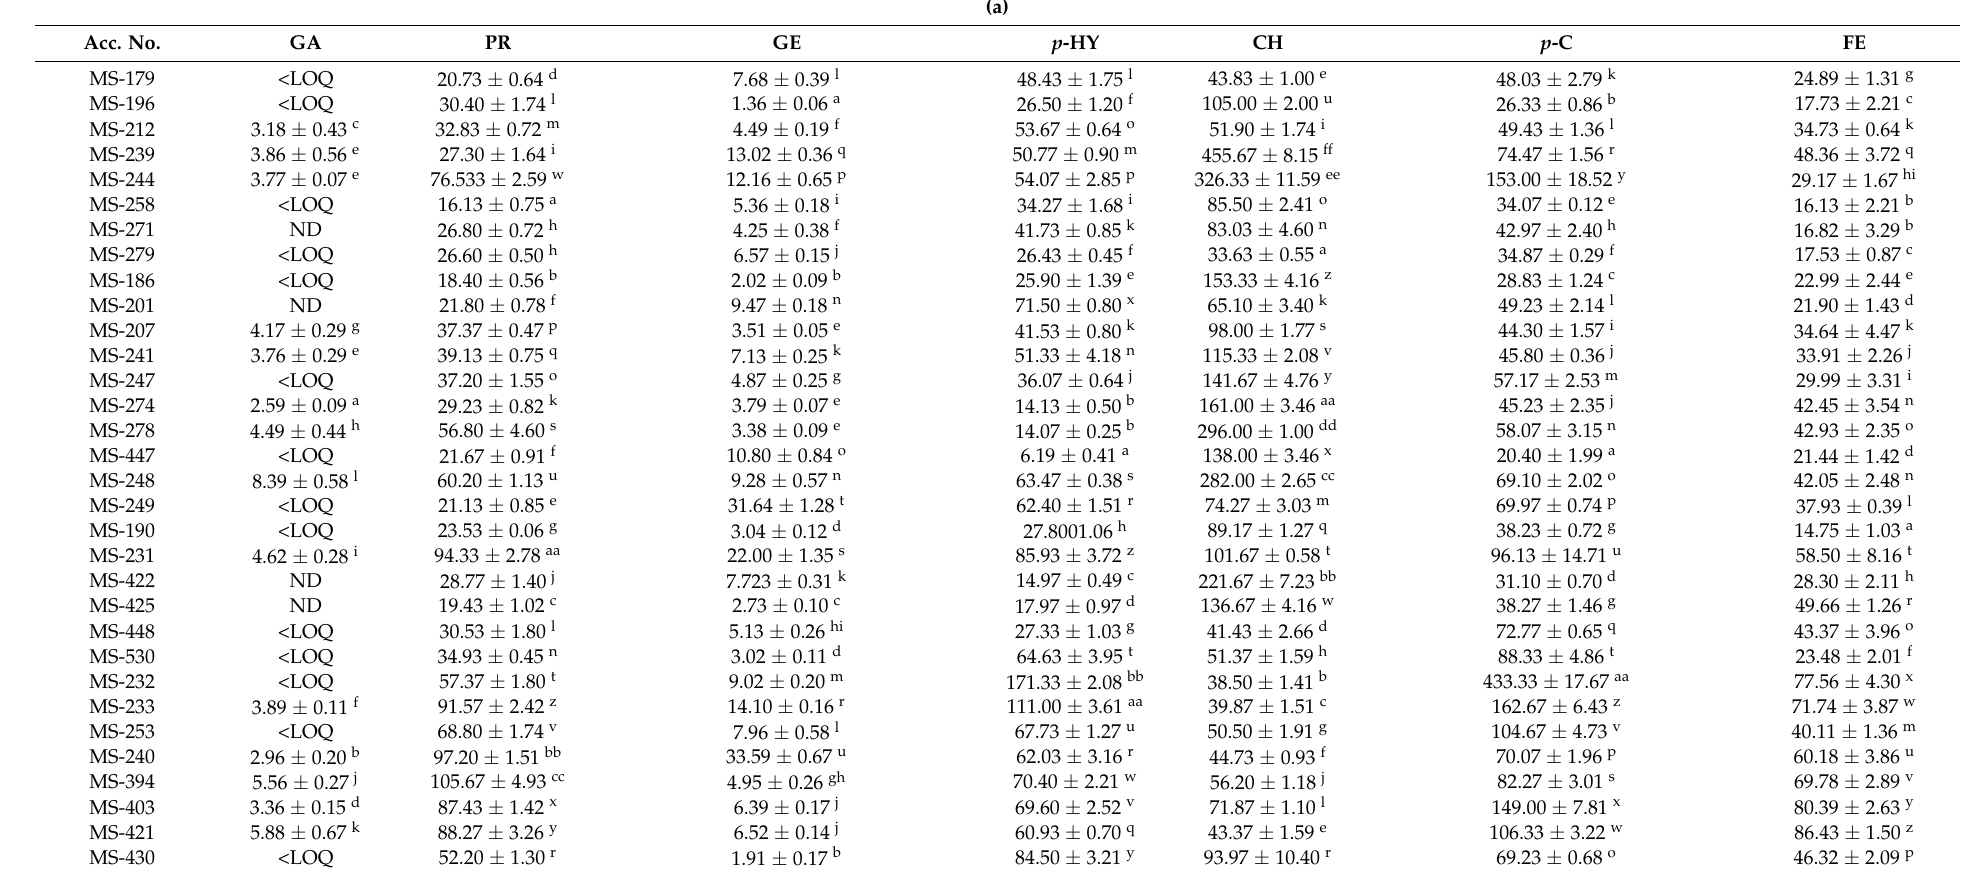
Table 7. Distribution of total phenolic compounds in selected M. sacchariflorus accessions.